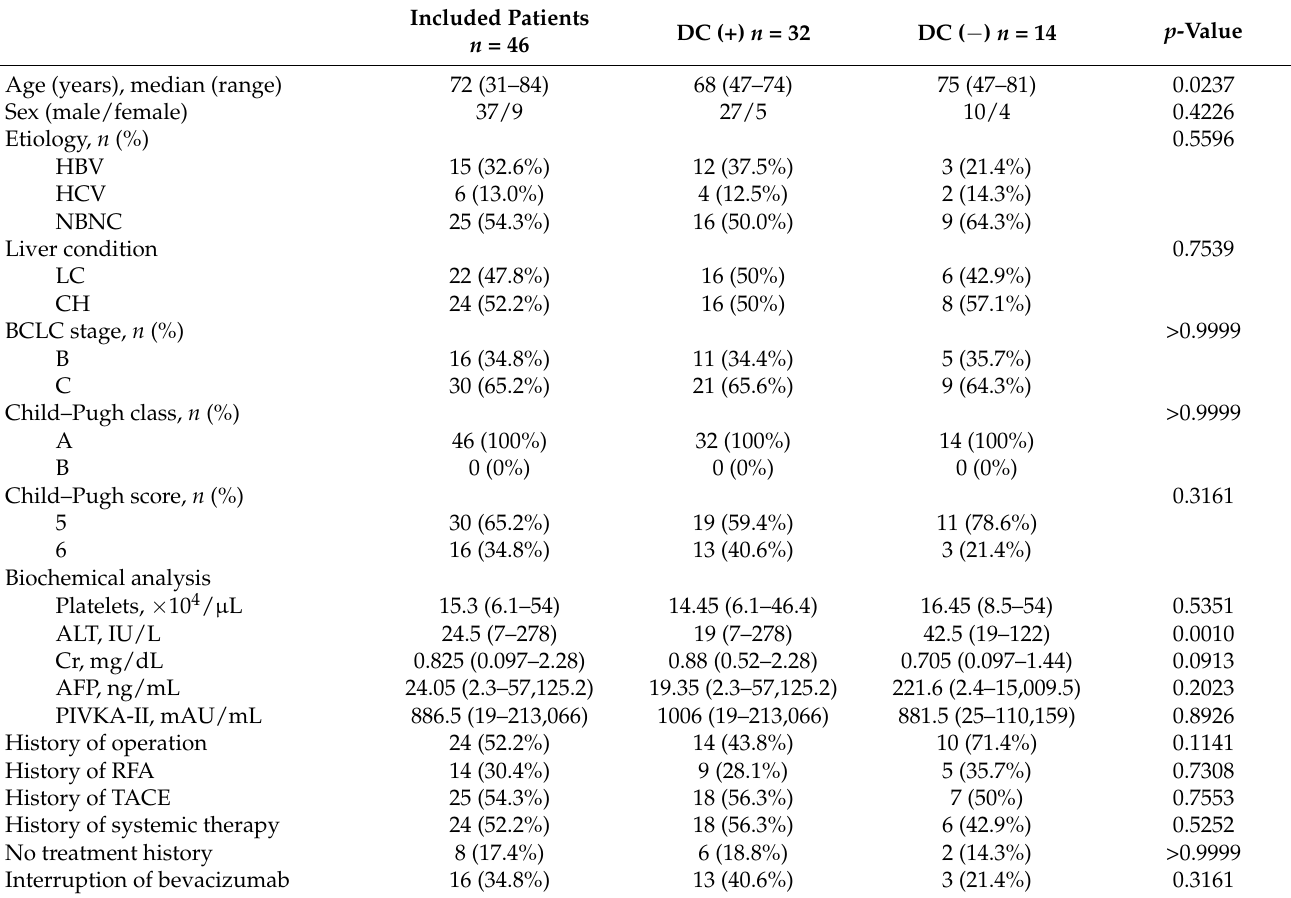
Table 1. Baseline patient characteristics in patients with and without DC.